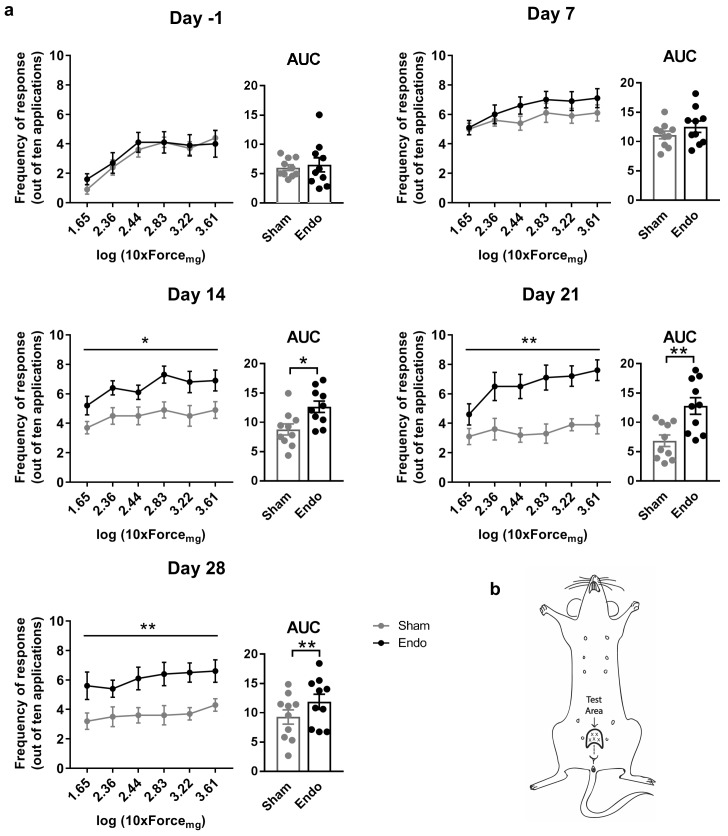
Nociceptive responses to abdominal mechanical stimulation with von Frey filaments.(a) Significantly higher frequency of responses and AUC was observed in endometriosis mice when compared to sham mice on days 14, 21 and 28 after the surgery. For each day, left panel is frequency of response to each von Frey filament and right panel is the corresponding mechanical sensitivity represented by the area under the curve of frequency of response to von Frey filaments. Higher values mean higher mechanical pain. (b) Site of application of the von Frey filaments (Test area). Error bars are mean ± SEM. For each day, one-way repeated measures ANOVA (left panels) and Student t-test (right panels). *p<0.05, **p<0.01 vs sham. Endo, endometriosis; AUC, area under the curve.